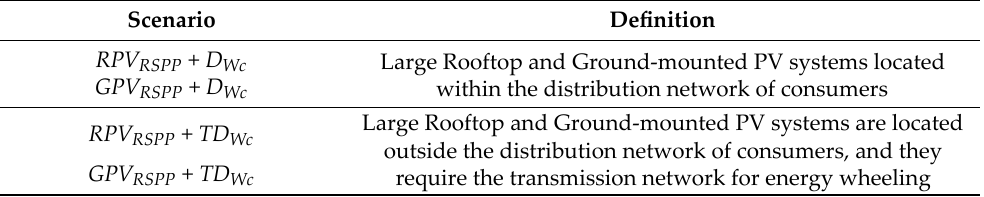
Table 5. Scenarios for sensitivity analysis.